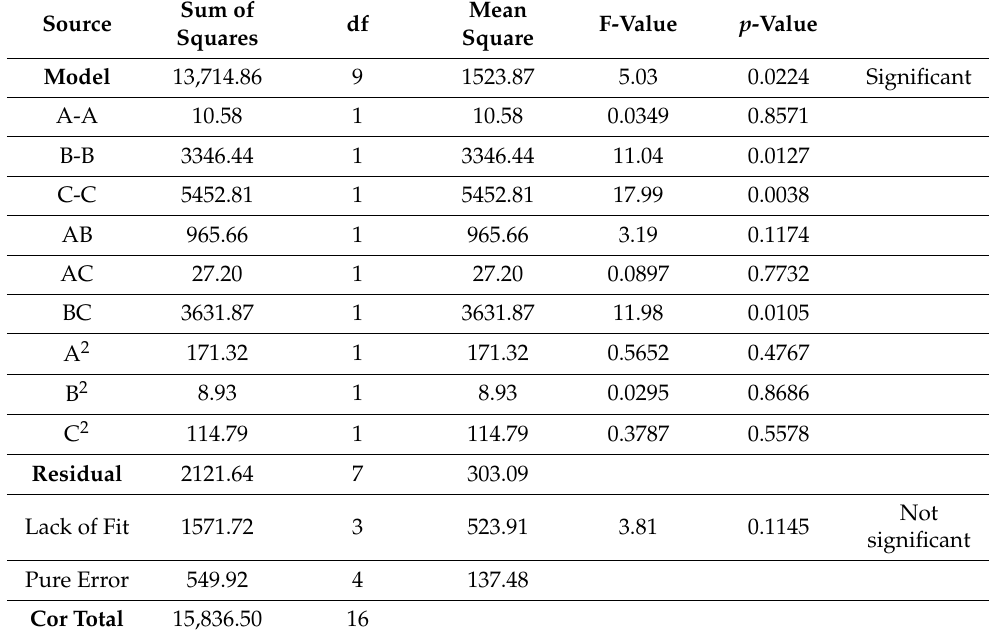
Table 7. ANOVA analysis for response surface model in relation to Cu 2+ biosorption onto